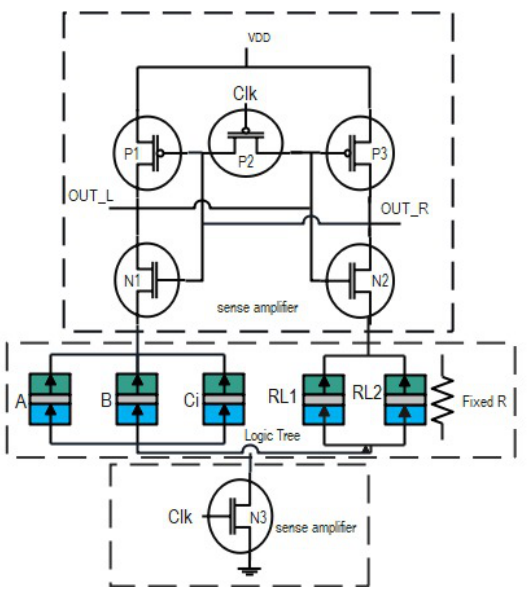
Figure 3. Schematic diagram of the proposed multi-functional